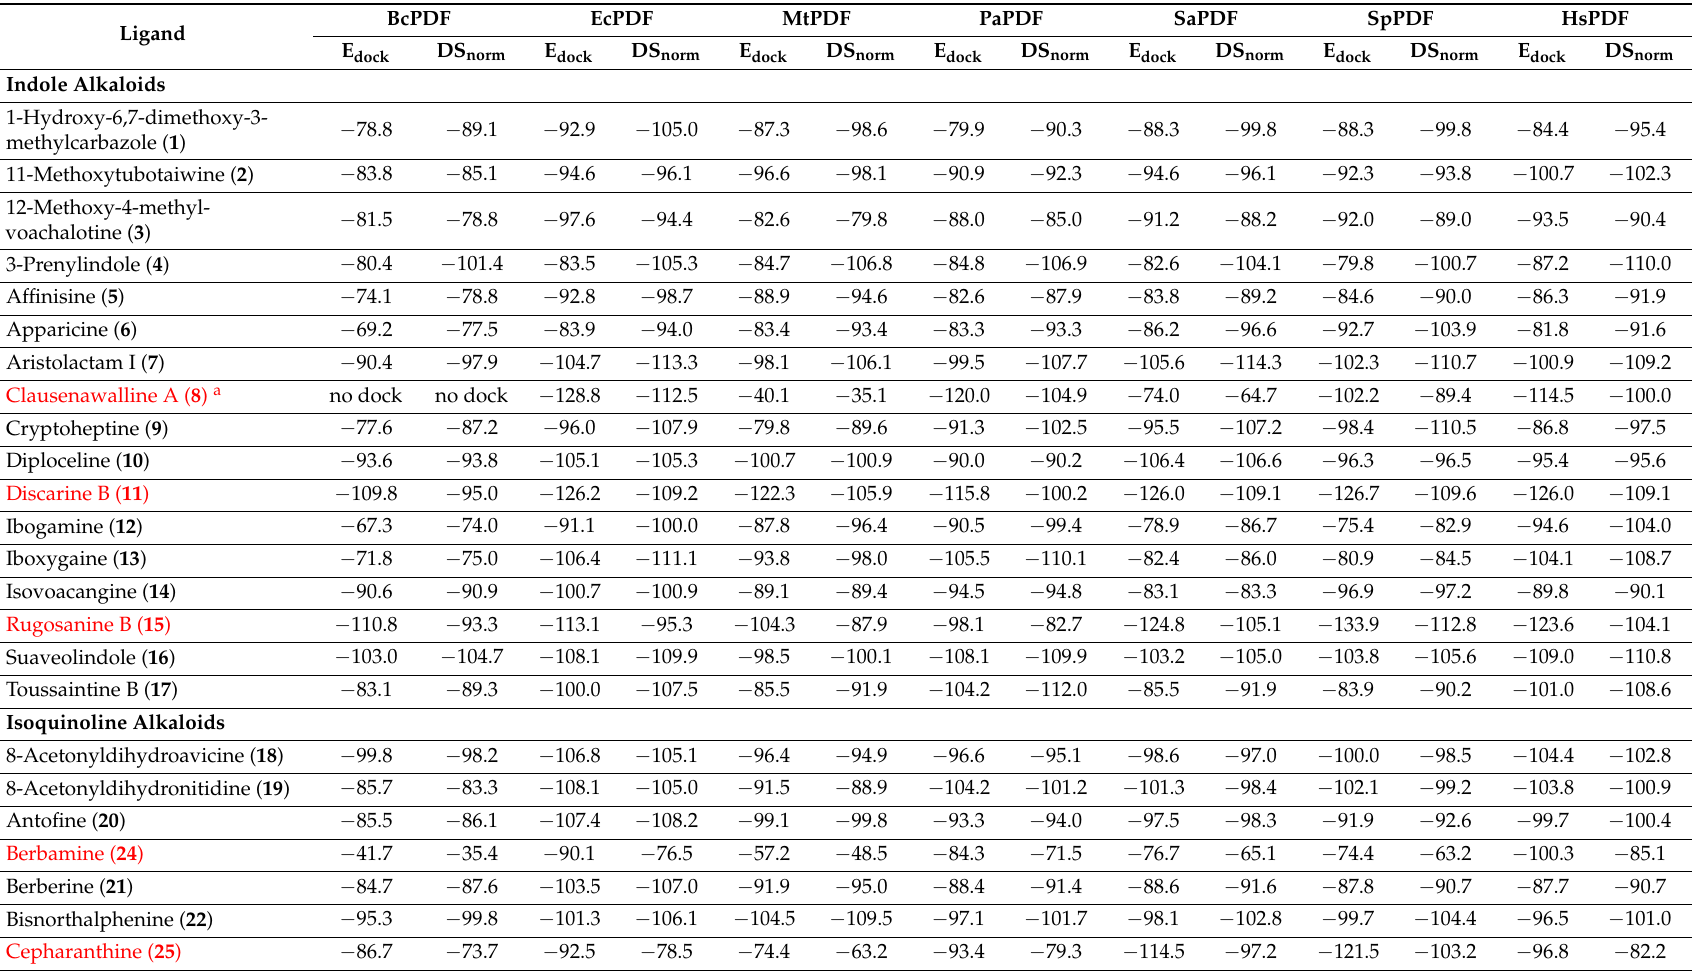
Table 2. MolDock molecular docking energies (E dock , kJ/mol) and normalized docking scores (DS norm ) for antibacterial phytochemical ligands with bacterial peptide